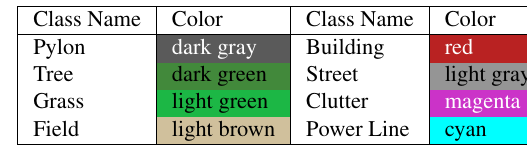
Table 3. Semantic classes and the according color coding.